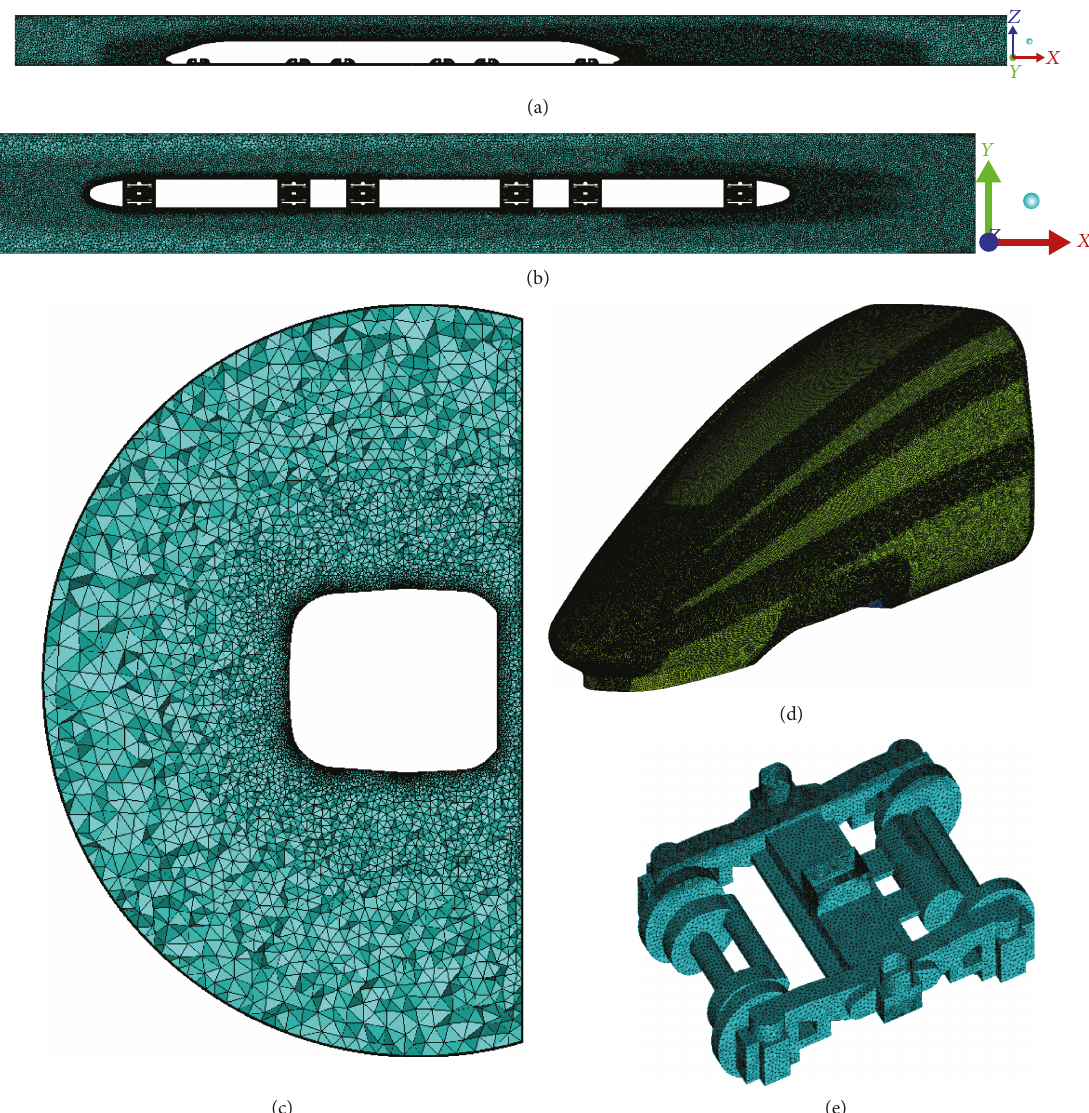
Figure 3: Mesh distribution: (a) longitudinal plane, (b) x - y plane with a height of 0.1 m from the ground, (c) cross section of the streamlined shoulder, (d) streamlined part, and (e)